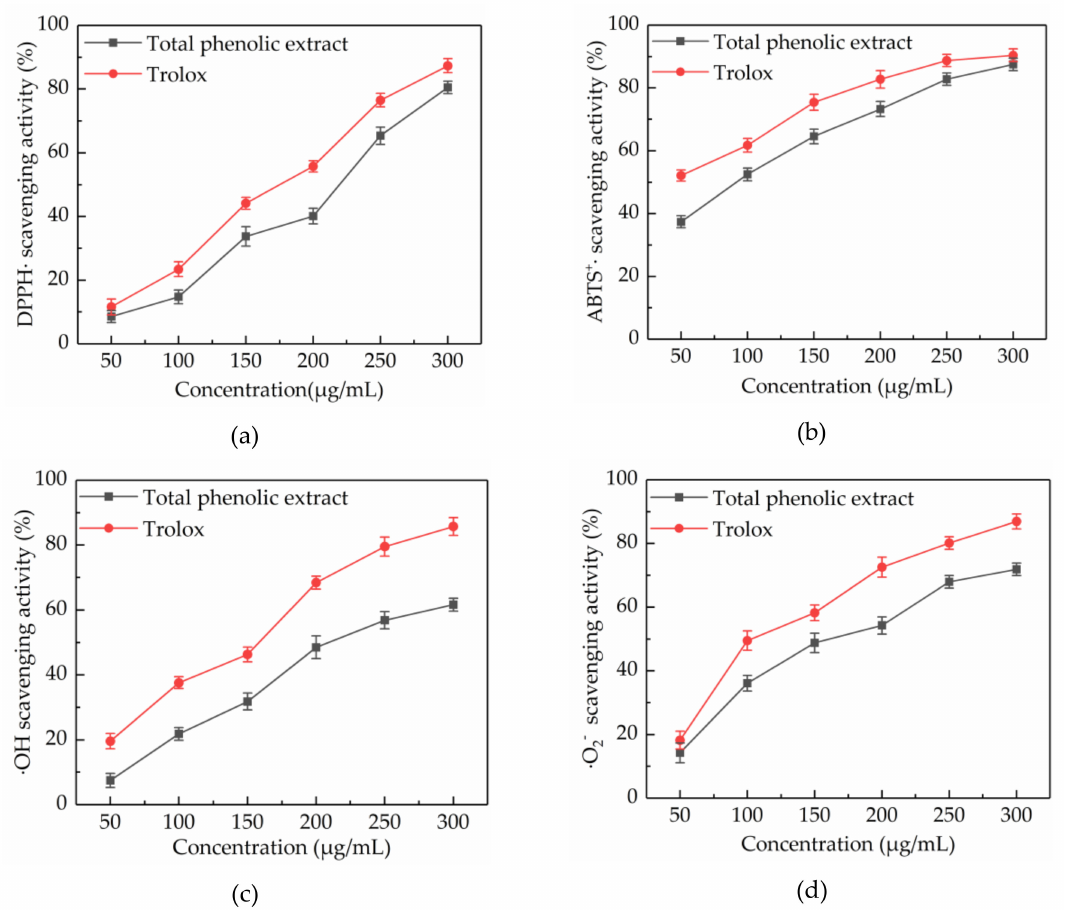
Figure 4. Free radical scavenging activities of total phenolic extract at concentrations of 50, 100, 150, 200, 250, and 300 µ g / mL. DPPH · scavenging activity ( a ), ABTS + · scavenging activity ( b ), · OH scavenging activity ( c ) and · O 2 − scavenging activity ( d